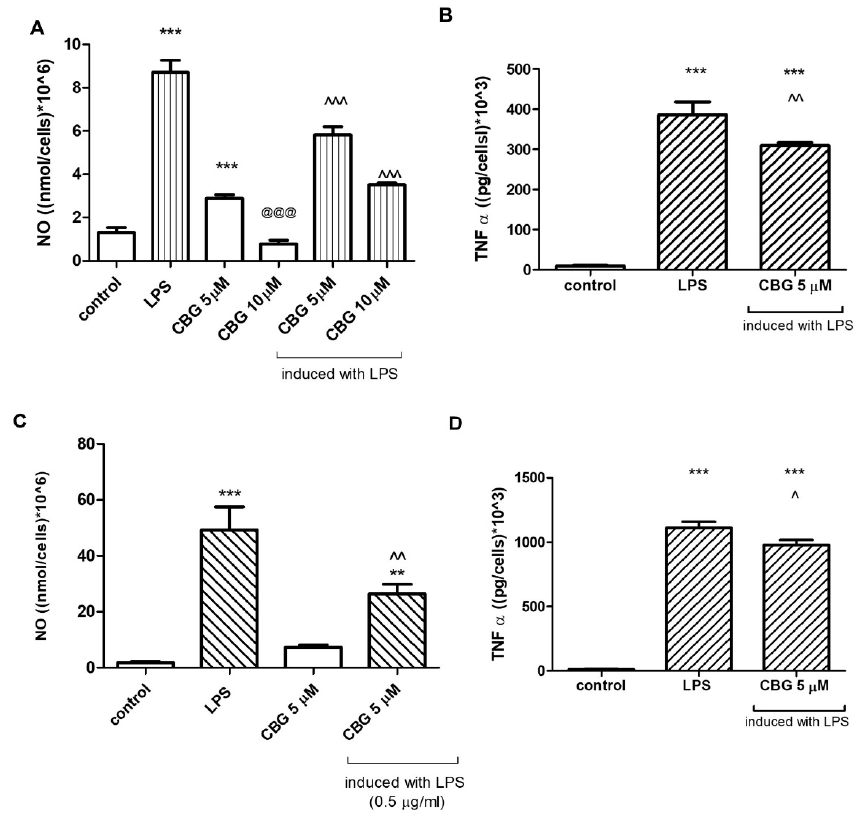
Figure 2. CBG decreased NO ( A , C ) and TNF - α ( B , D ) production by LPS-induced BV2 microglia ( A , B ) and in primary rat glial cells ( C , D ). Cells were pre-incubated with SFM for 4 h and then incu- bated for 22 h with 7 ng/mL LPS ( A , C ) and 0.5 µg/mL LPS ( B , D ) in the presence or absence of 5 or 10 µM CBG. Culture media were analyzed for NO ( A , C ) and TNF - α ( B , D ) levels and normalized to cell counts. Means ± SEM of representatives of three ( A , C ) or two ( B , D ) independent experiments are presented (n = 6). One - way ANOVA and a Tukey – Kramer multiple comparison test were per- formed for statistical significance. *** p < 0.001 vs. control; ** p <0.005 vs. control; @@@ p < 0.001 vs. CBG 5 µM; ^^^ p < 0.001 vs. LPS; ^^ p < 0.005 vs. LPS; ^ p < 0.05 vs. LPS.